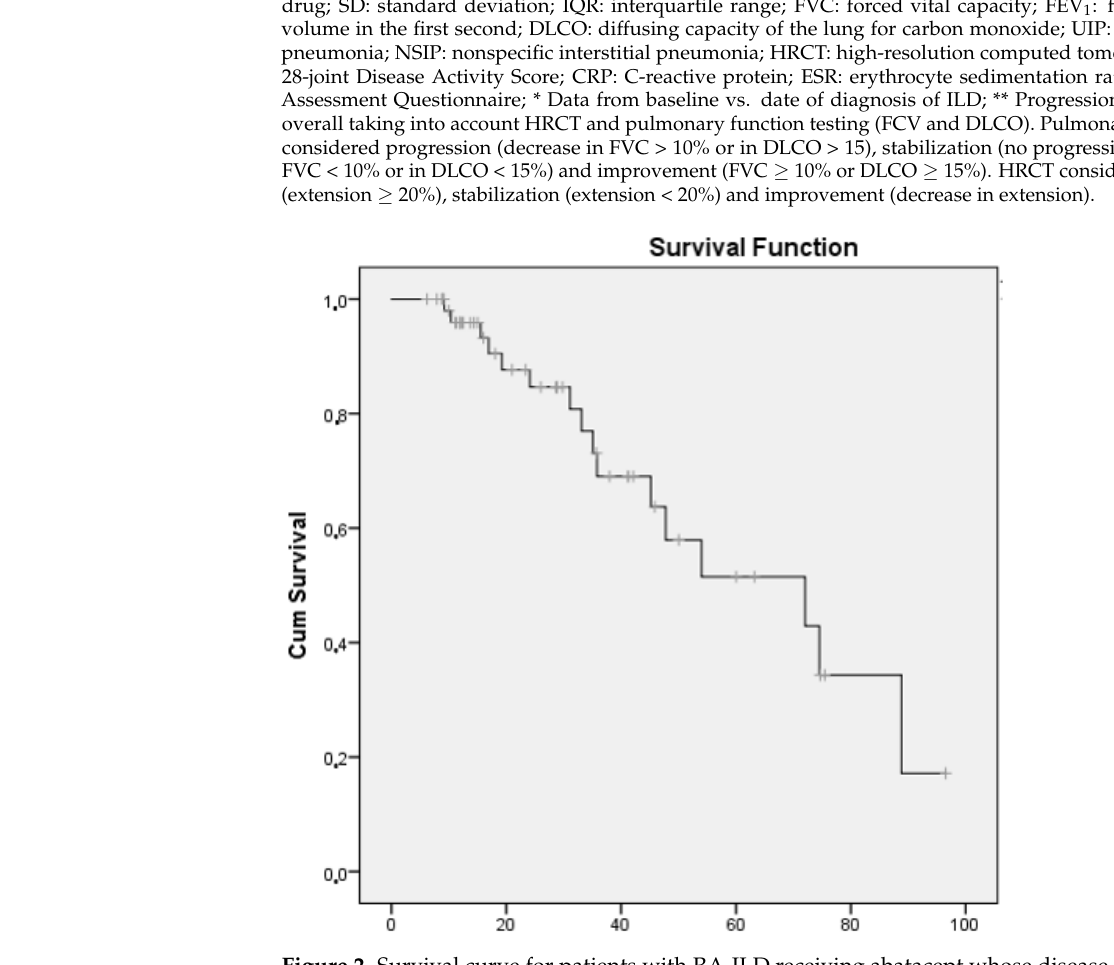
Figure 2. Survival curve for patients with RA-ILD receiving abatacept whose disease had progressed or who had died.